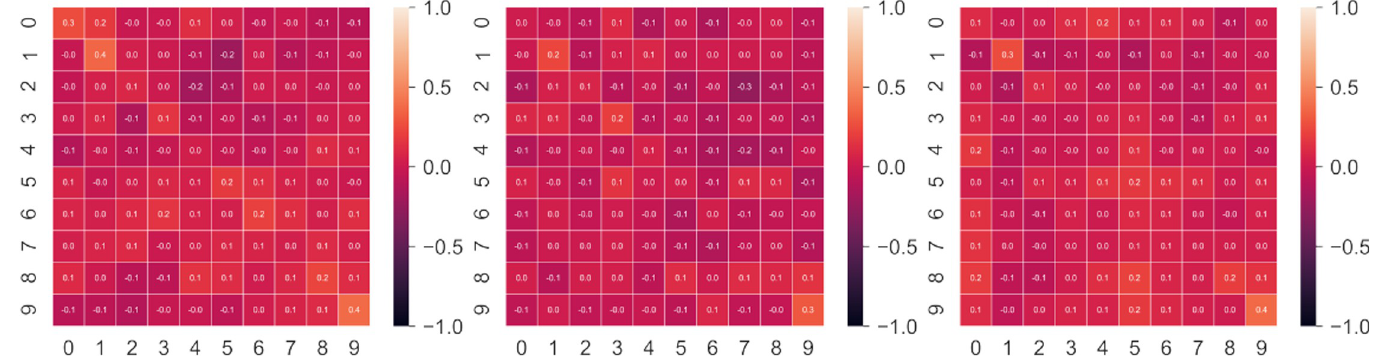
Fig 2. Correlation matrices. Correlation matrices between honest and dishonest responses in the CC, JIS and JIHO datasets respectively, from left to right. Correlation between responses in the honest and dishonest condition is virtually nonexistent, rendering the identification of the honest responses from the dishonest ones a difficult task.